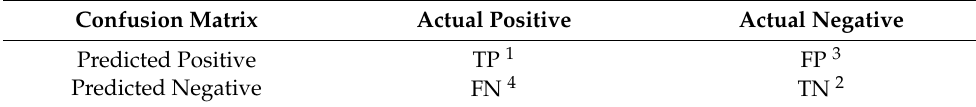
Table 2. Confusion matrix. Confusion Matrix Actual Positive Actual Negative Predicted Positive TP 1 FP 3 Predicted Negative FN 4 TN